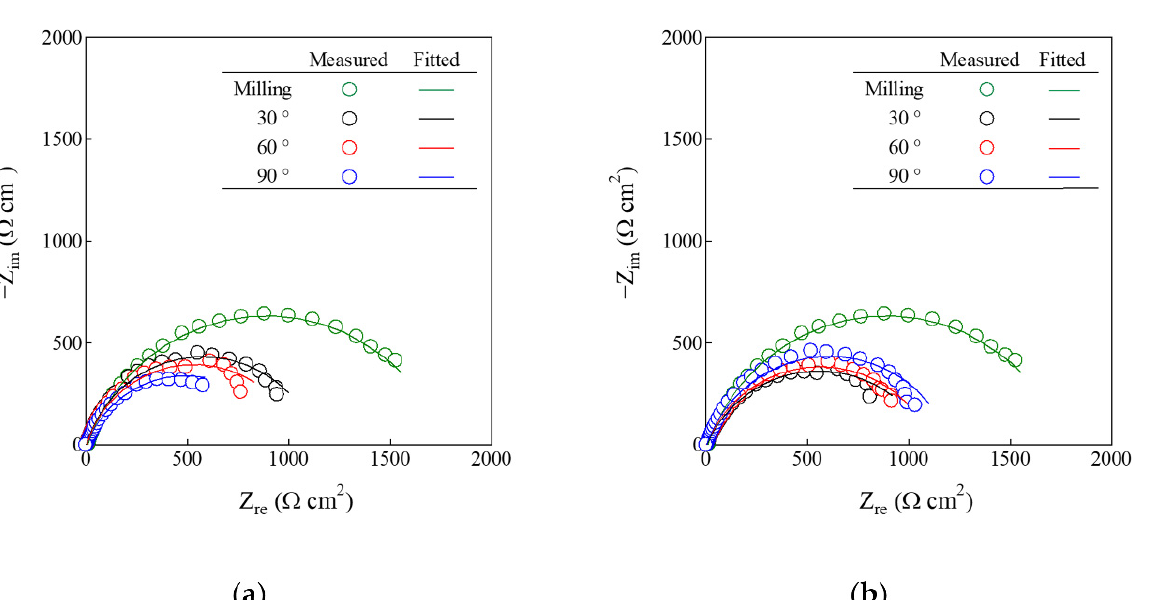
Figure 12. Microscopic images of the cross-section of the blasted specimens after immersing in 3.5 wt% NaCl solution: ( a ) MST, ( b ) MAL.